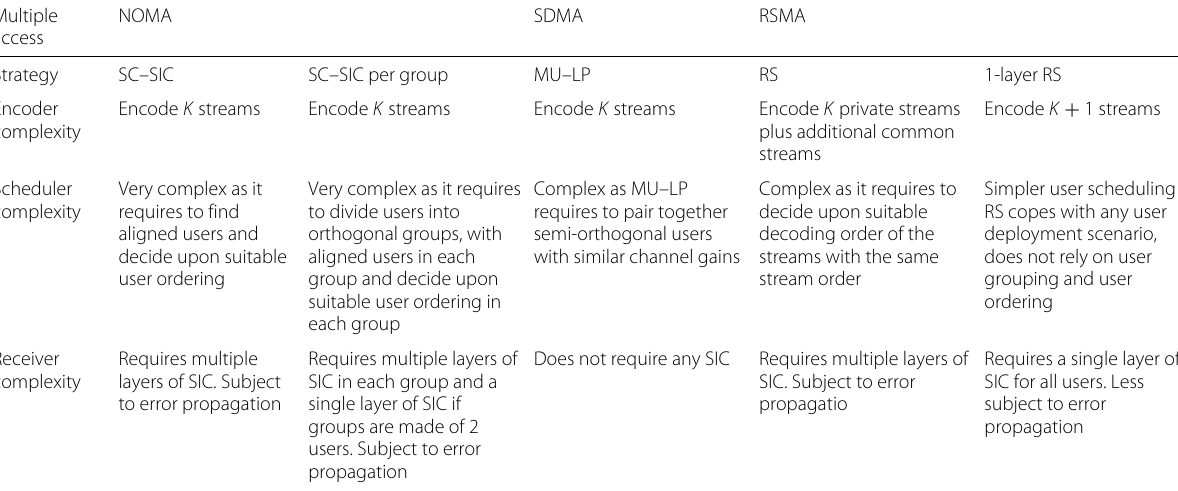
Table 2 Qualitative comparison of the complexity of different strategies Multiple NOMA SDMA RSMA access Strategy SC–SIC SC–SIC per group MU–LP RS 1-layer RS Encoder Encode K streams Encode K streams Encode K streams Encode K private streams complexity